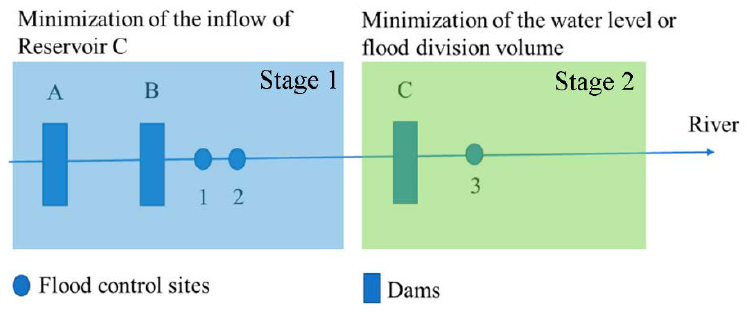
Figure 1. Diagram of dams and flood control points.